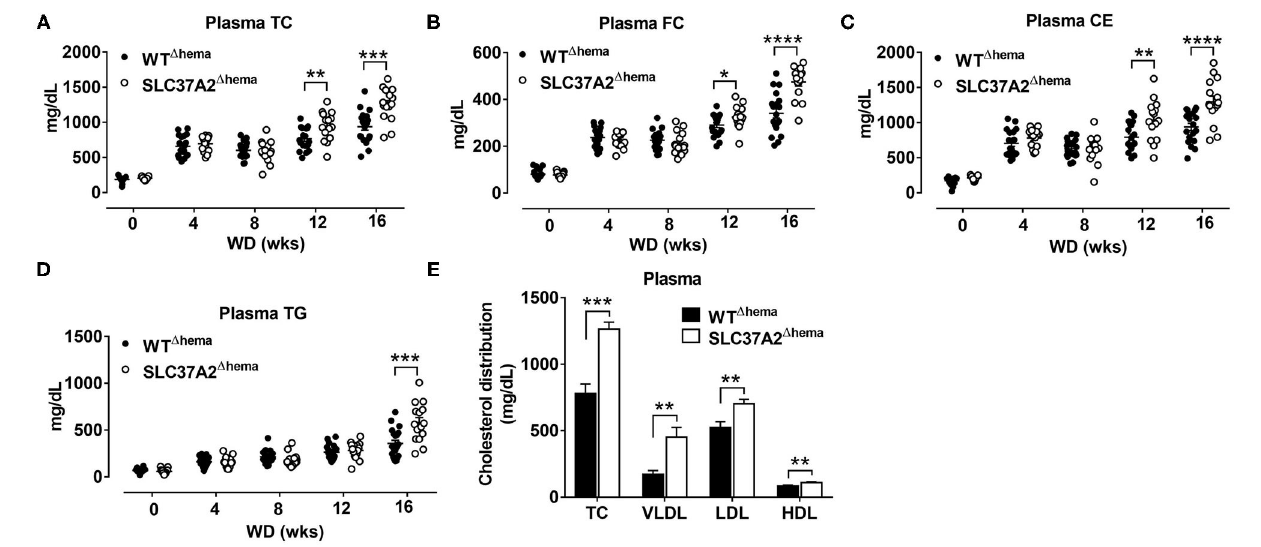
FIGURE 1 | Hematopoietic cell-specific SLC37A2 deletion increases plasma lipids in WD-fed Ldlr − / − mice. Hematopoietic SLC37A2 knockout (SLC37A2 1 hema ) and control (WT 1 hema ) Ldlr − / − mice were switched from a standard laboratory diet to high-fat WD for 16 wks to promote the development of advanced atherosclerosis. (A–D) Fasting (4h) plasma total cholesterol (TC), free cholesterol (FC), cholesterol ester (CE), and triglyceride (TG) concentrations were measured by enzymatic assays over time (0-16 wks) ( n = 12-16). (E) Plasma cholesterol distribution among lipoproteins after 16 wks of WD feeding was determined after fractionation of plasma by fast protein liquid chromatography ( n = 6-8). Data are expressed as mean ± SEM. * P < 0.05, ** P < 0.01, *** P < 0.001, **** P < 0.0001. The mixed-effects models were used to compare lipids variables between genotype groups at each time point. HDL indicates high-density lipoprotein; LDL, low-density lipoprotein; and VLDL, very-low-density